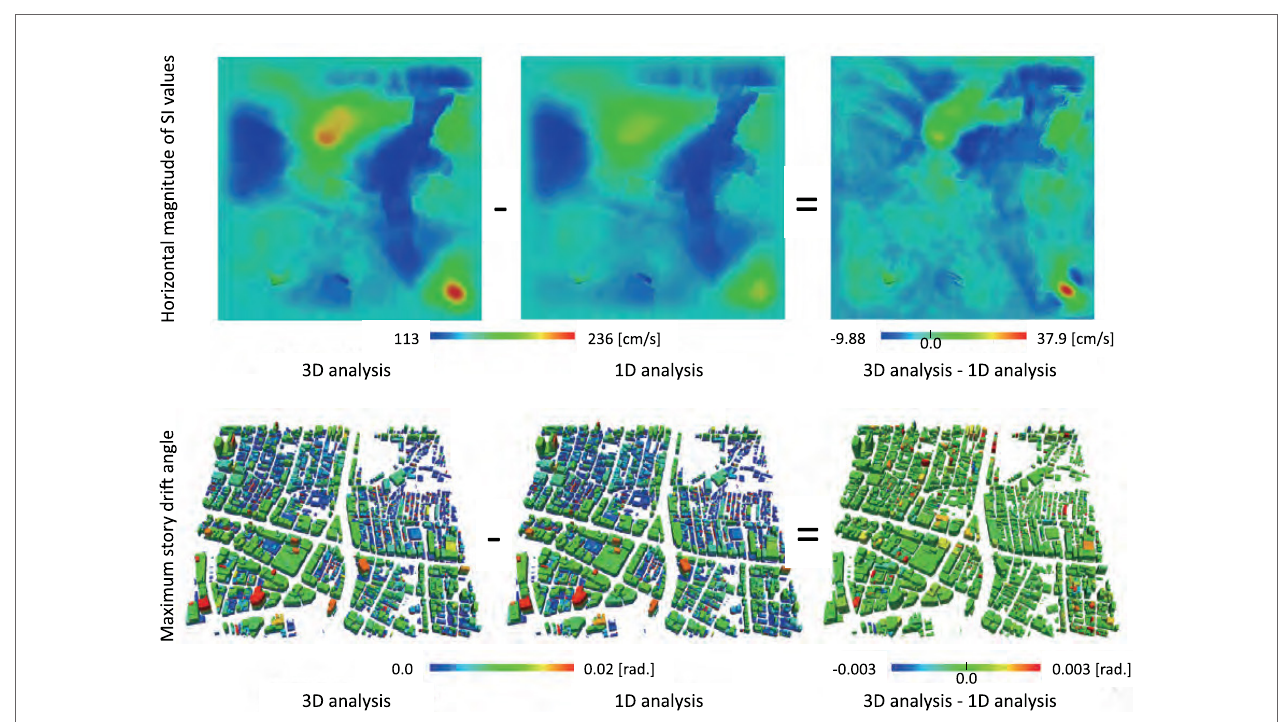
FigUre 10 | Comparison of ground motion simulation and conventional 1D analysis for estimation of earthquake hazard and